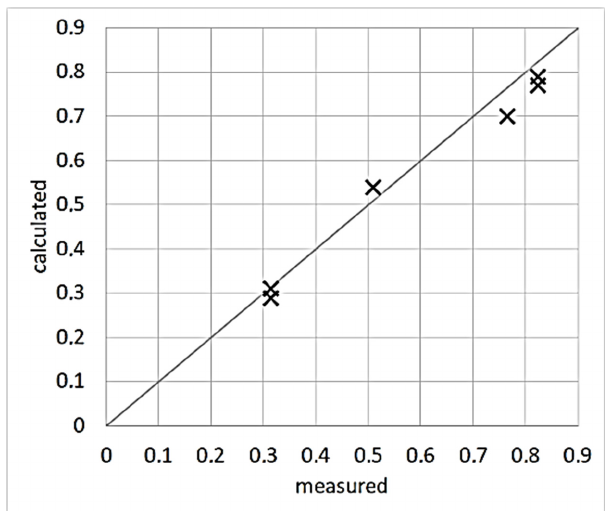
work. Data referring to laser scans on bare disks have been used.